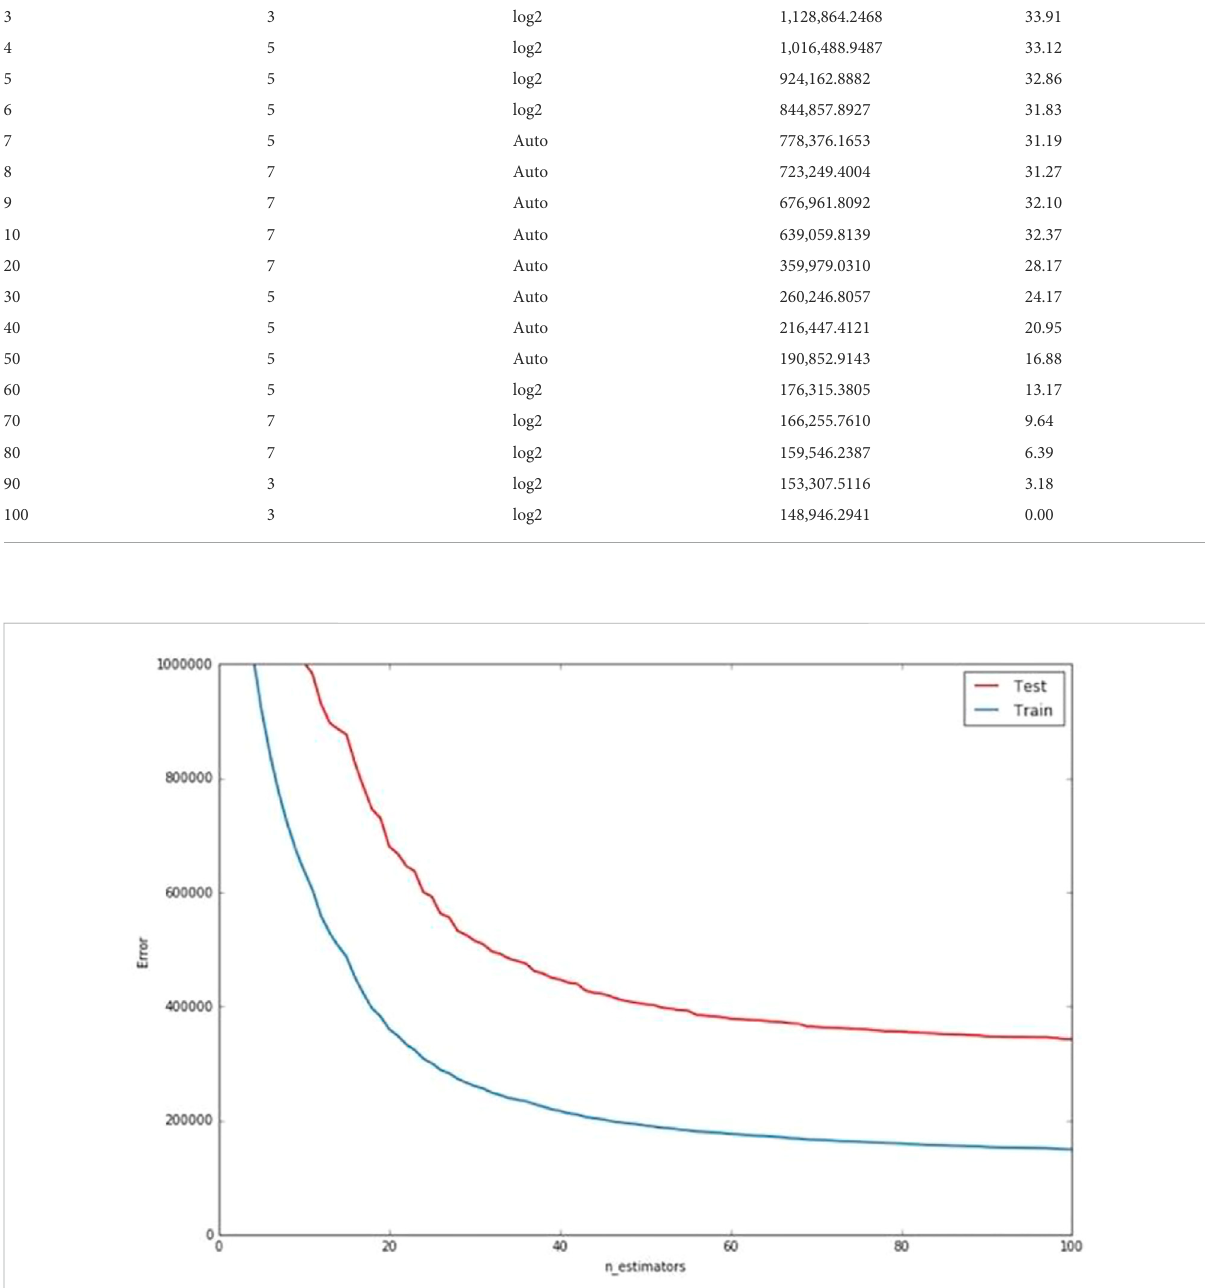
FIGURE 4 Error variation with parameters